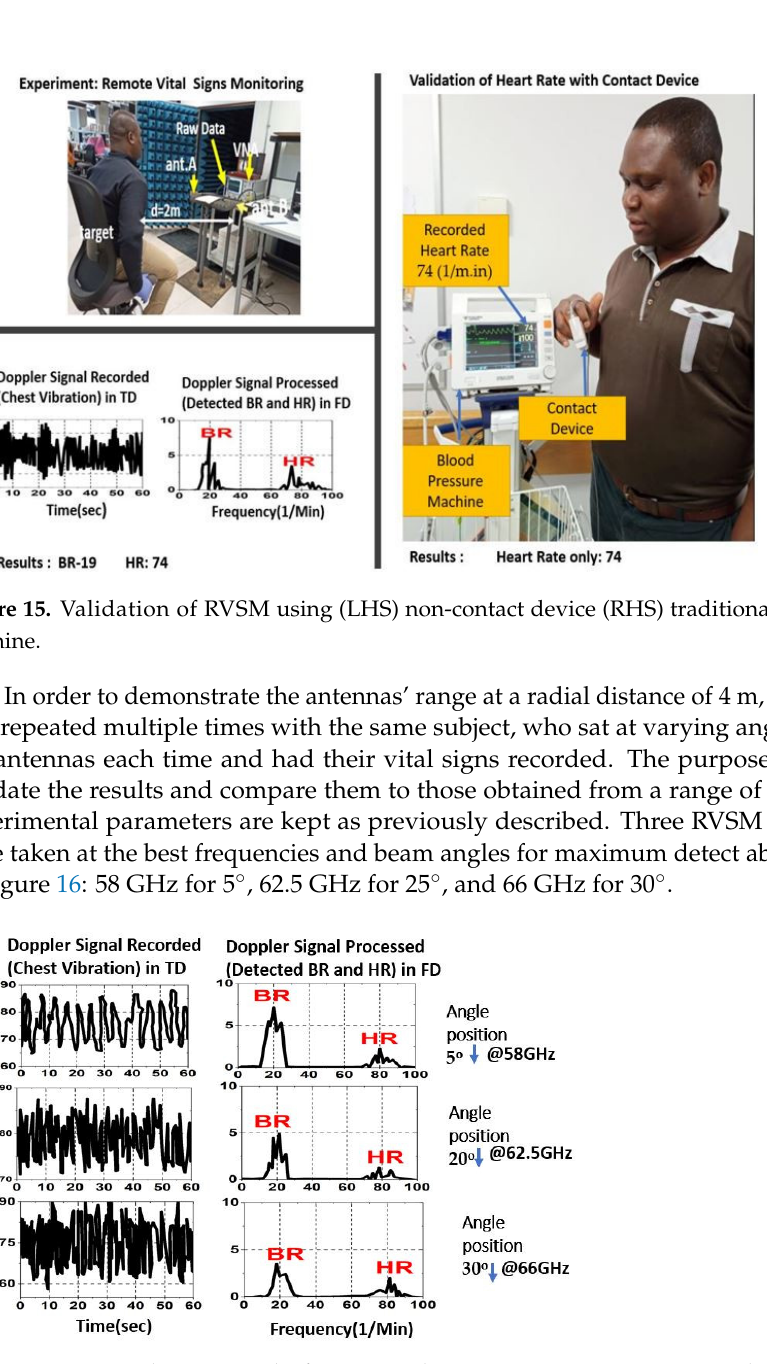
Figure 16. Measured RVSM results from a 4 m distance at 58 GHz, 62.5 GHz, and 66 GHz. Table 2. Measured BR and HR with HIS-PRS LWA operation results at angles of 5 ◦ , 10 ◦ , 15 ◦ , 20 ◦ , and 30 ◦ for each